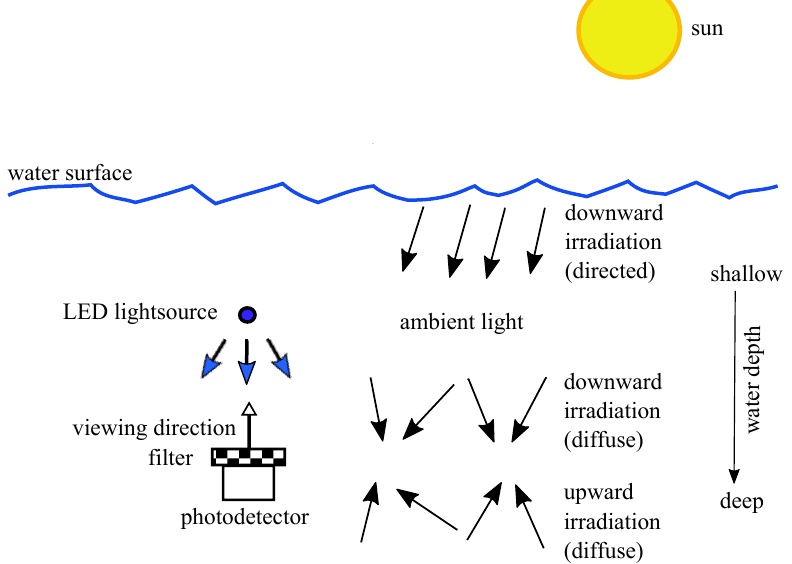
Figure 16. Picture is showing the general scenario and illustrates the environmental